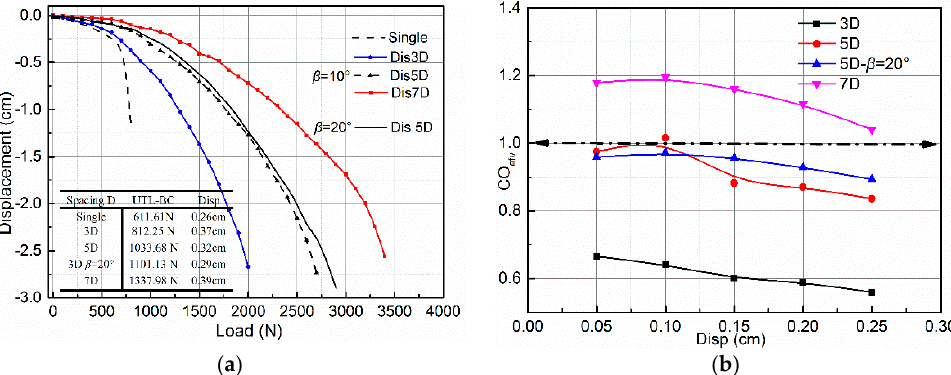
Figure 7. ( a ) Load–displacement of pile cap, and ( b ) variation in symmetric batter pile group efficiency with pile spacing.